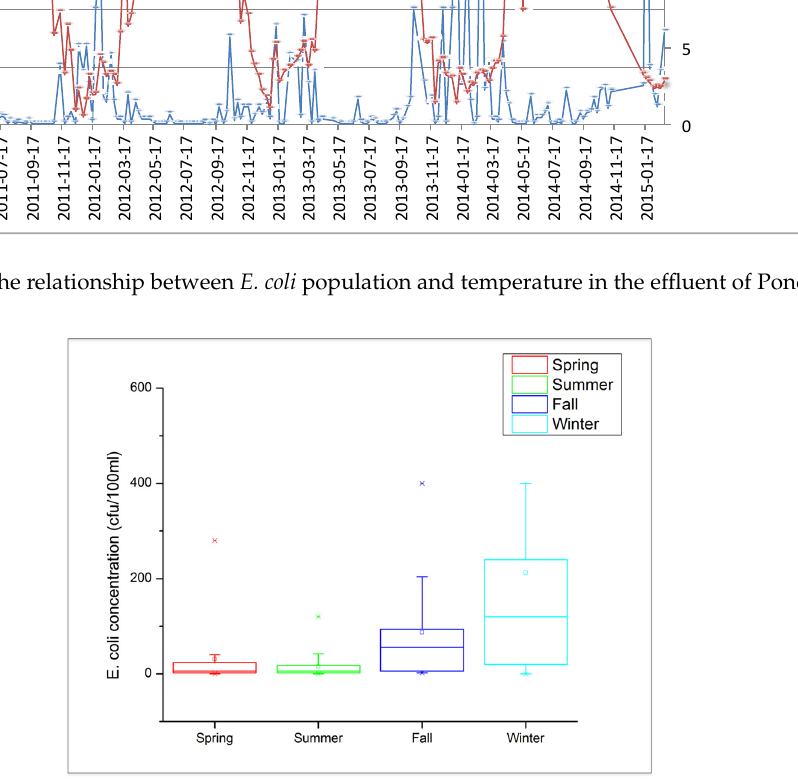
Figure 9. Seasonal (Spring: April–June; Summer: July–September; Fall: October–December; Winter: January–March) E. coli concentrations in Pond 1 during the monitoring period.